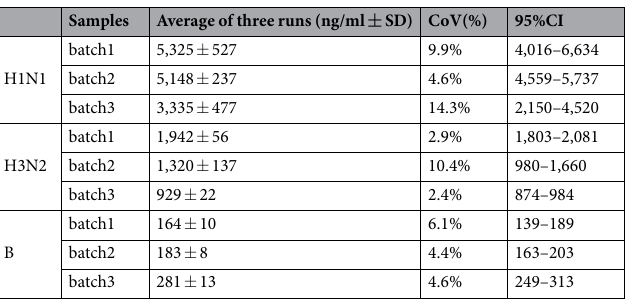
Table 1. Reproducibility of the slot blot assay. Note: The result of each batch was obtained from three runs of